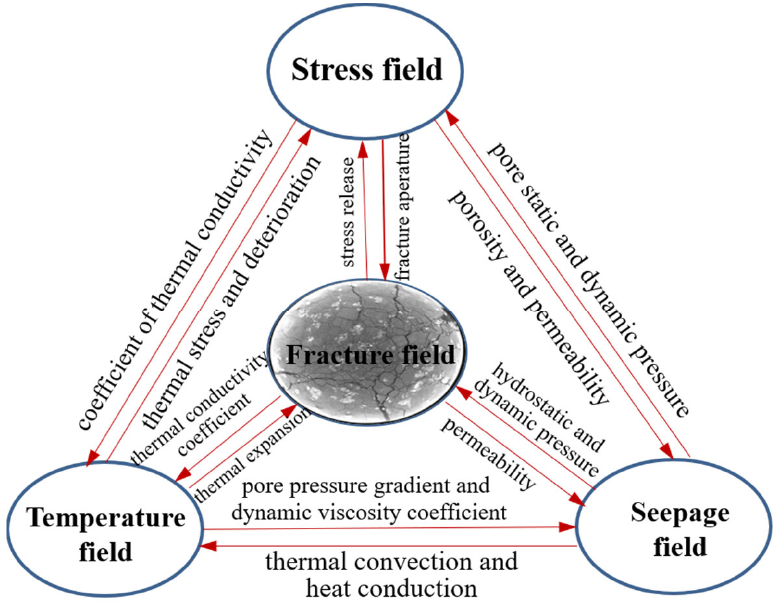
Figure 3. Cross-couplings in heating-enhanced shale-gas recovery. Figure 3. Cross ‐ couplings in heating ‐ enhanced shale ‐ gas recovery.